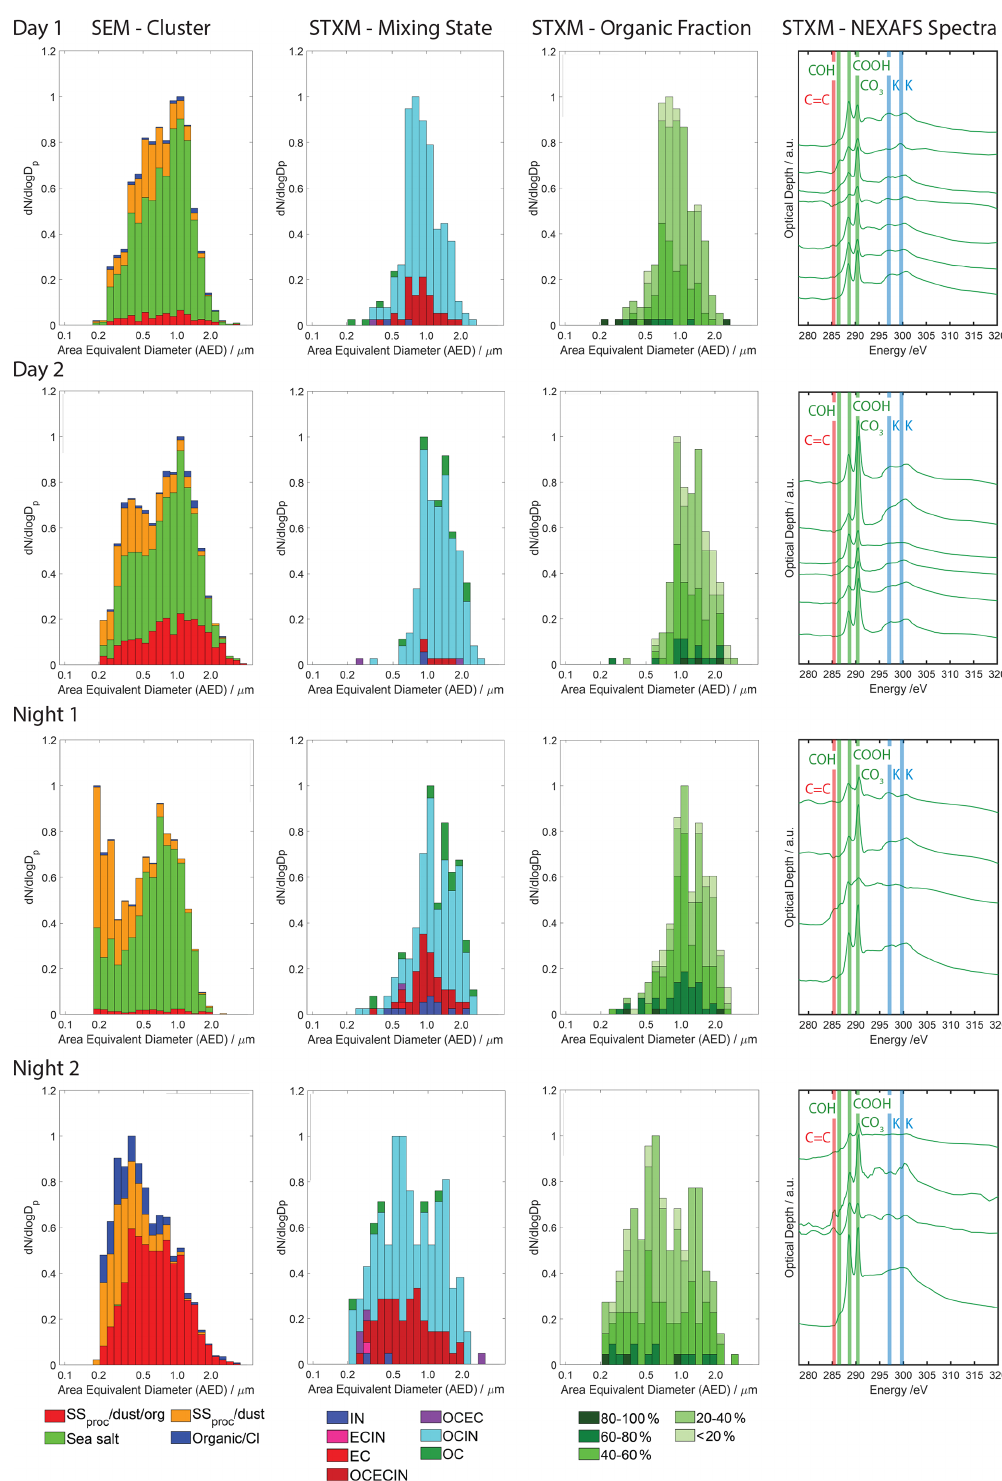
Figure 3. Size-resolved particle composition for particle samples determined by micro-spectroscopic single-particle analysis as a function of area-equivalent diameter (AED). From left to right: first column: CCSEM/EDX particle-type classes. Second column: STXM/NEXAFS- derived groups of particles with different mixing states: IN – inorganic, EC – elemental carbon, OC – organic carbon. Third column: organic volume fraction (OVF). Fourth column: representative NEXAFS spectra at the carbon